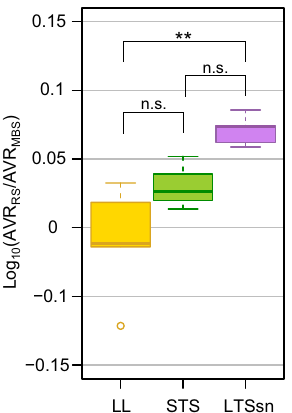
Figure 5. Stress-response weighed expression in LTSsn. log10 scaled ratio between the average mRNA signals of all members in “macromolecule biosynthetic process (GO:0009059),” designated as “AVR MBS ”, or “response to stress (GO:0006950),” designated as “AVR RS ”. Error bars indicate the standard deviation of average signals among the biological replicates. Asterisks indicate statistical significance levels according to Tukey’s HSD test (**, p < 0.01; *, p <